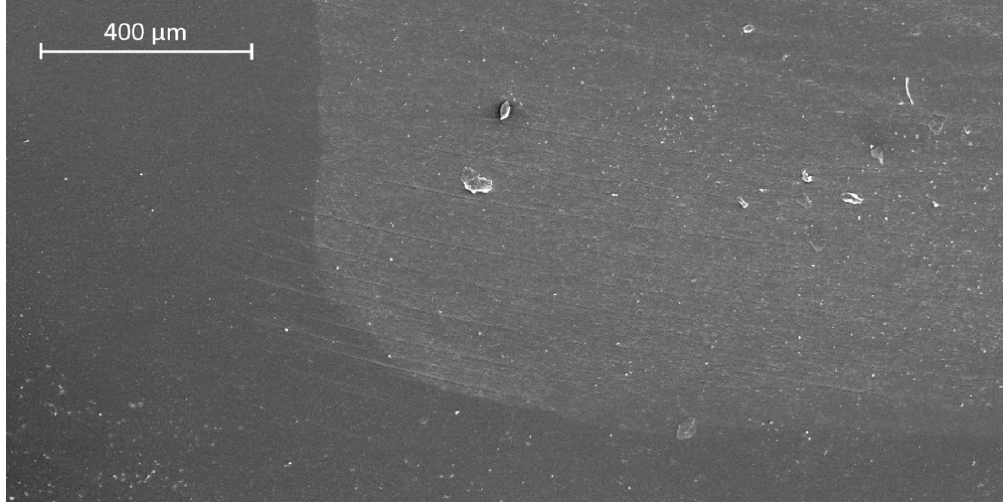
Figure 6. SEM image of continuous margin in dentin (group 4: Admira Fusion x-tra (AFX), after thermo-mechanical loading).